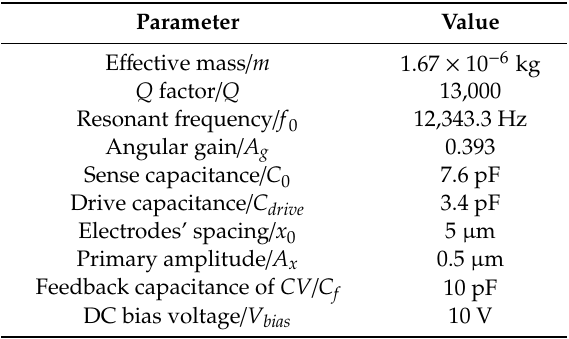
Table 1. Key parameters of disk resonator and its sensing system.